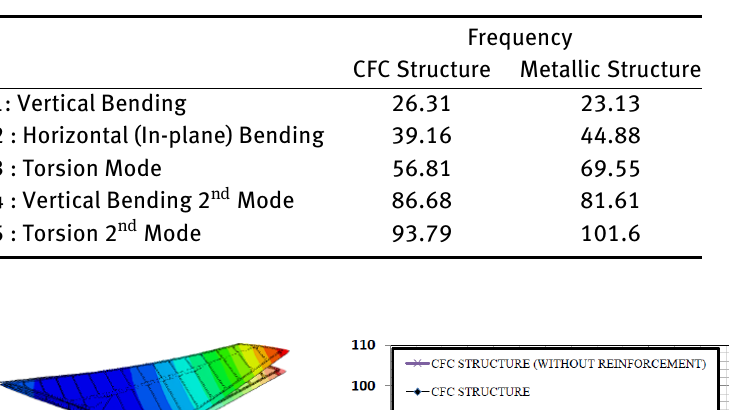
Table 5: Modal Frequencies for CFC and Metallic Structure